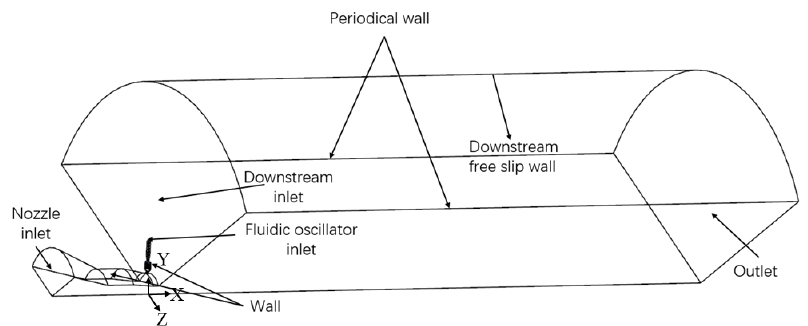
Figure 2. Computation domain.